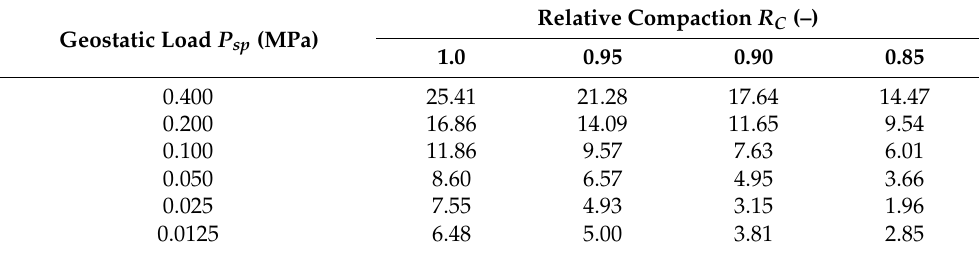
Table A4. Secant Constrained Fly Ash and Bottom Slag (FA + BS) Modulus, E ode .